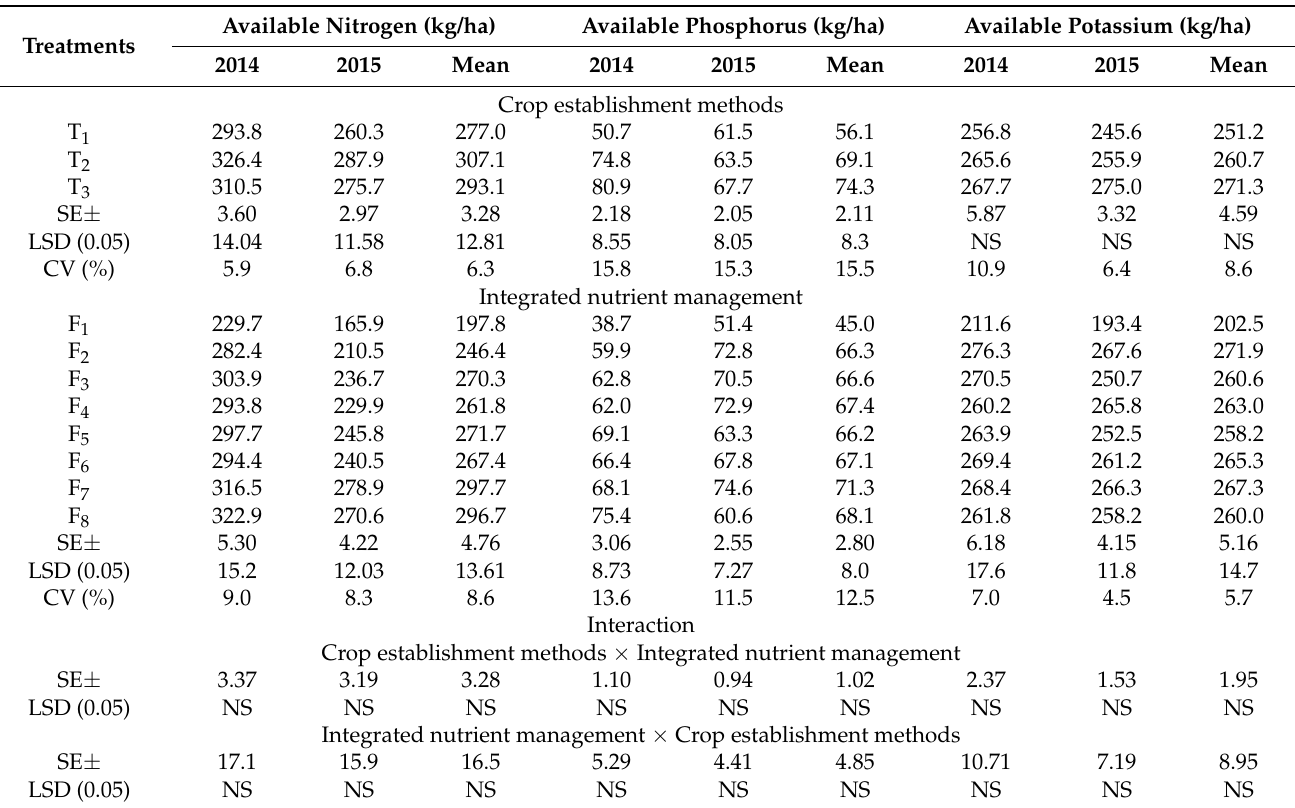
Table 5. Crop establishment methods and integrated nutrient management influence on available nitrogen, phosphorus, and potassium status of soil after harvest of